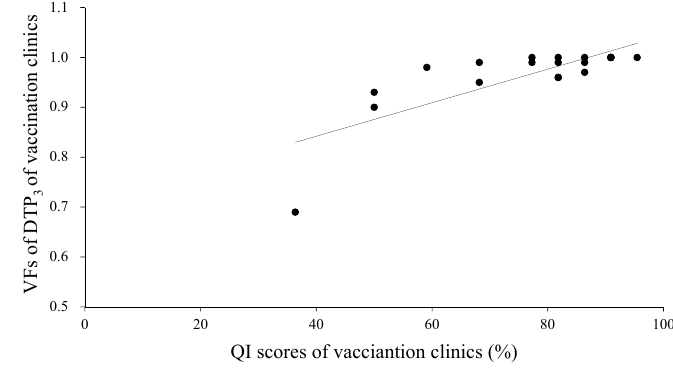
Figure 4. Correlation between the VF of DTP 3 and the quality index (QI) score at the vaccination clinic level, from the DQA in Shangyu District, 2014.